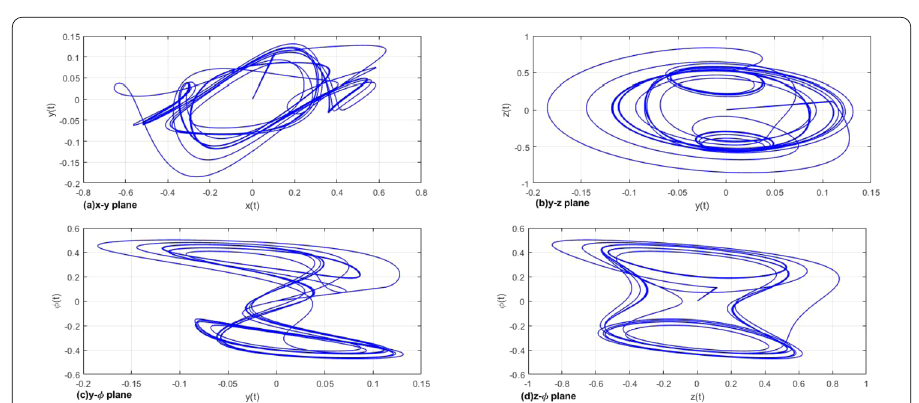
Figure 8 Phase portrait of model (21) for β 2 = 13.02